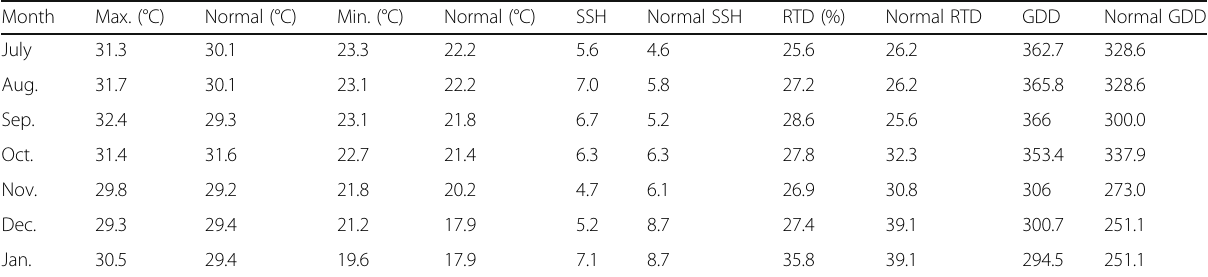
Table 8 Weather parameters of experimental years and 50 years of normal Month Max. (°C) Normal (°C) Min. (°C) Normal (°C) SSH Normal SSH RTD (%)